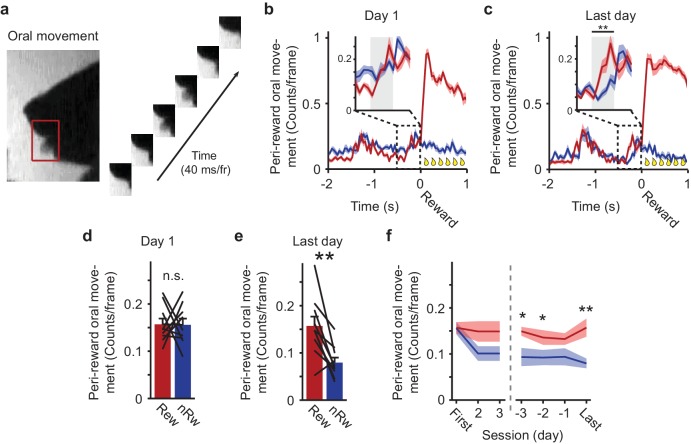
Peri-reward oral-movement during visual conditioning.(a) Example of a putative lick. Licks were detected in the area, delineated by the position of the lower and upper jaw during visually identified licks (red box; manually outlined per video). (b) Peri-reward oral movement (putative licks) in the first conditioning session. A large peak in oral movement indicates reward consumption at the time of reward delivery (t = 0). The inset displays putative licks from −0.5 to 0 s before reward, with the gray region indicating the anticipatory period from −0.4 to −0.16 s before the arm reached the reward position. Red: Rewarded trials; Blue: non-rewarded trials. (c) Same as b) but for the last conditioning session of each mouse. Pre-reward oral-movement was stronger in the anticipatory period of rewarded trials compared to non-rewarded trials (**p<0.01, WMPSR test). (d) Mean oral movement in the anticipatory period of the first training session. Single lines represent individual mice. (e) Mean oral-movement in the anticipatory period of the last conditioning session. All but one animal showed more intense anticipatory oral-movement in rewarded trials compared to non-rewarded trials (**p<0.01, WMPSR test). (f) Difference in oral-movement during the first three and last four conditioning sessions (*p<0.05, **p<0.01; WMPSR test). All data are presented as mean ± SEM across mice.